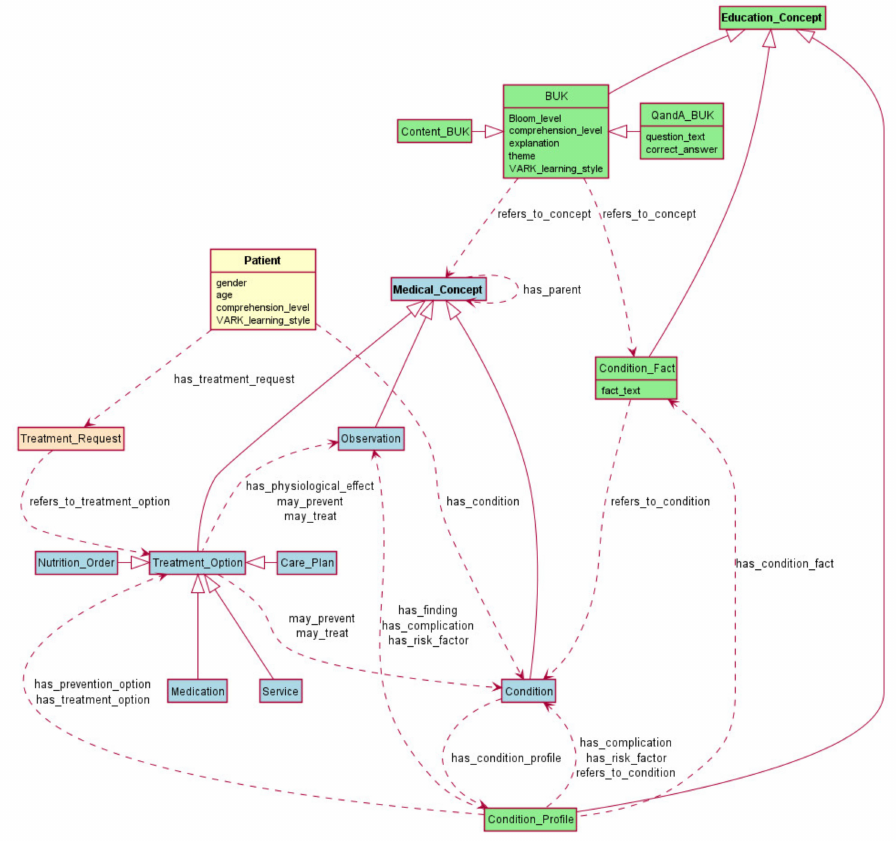
Figure 1. eLearning ontology (selected auxiliary concepts and relations have been removed for